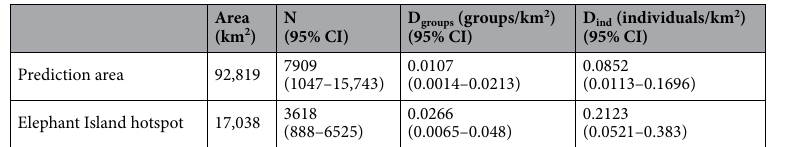
Table 4. Predicted abundance and density of fin whales in the prediction area (i.e., the area for which predictions were associated with a CV < 100), and for the hotspot around Elephant Island. N = abundance, D = density. 95% confidence intervals given in brackets. Predictions are based on model g8.